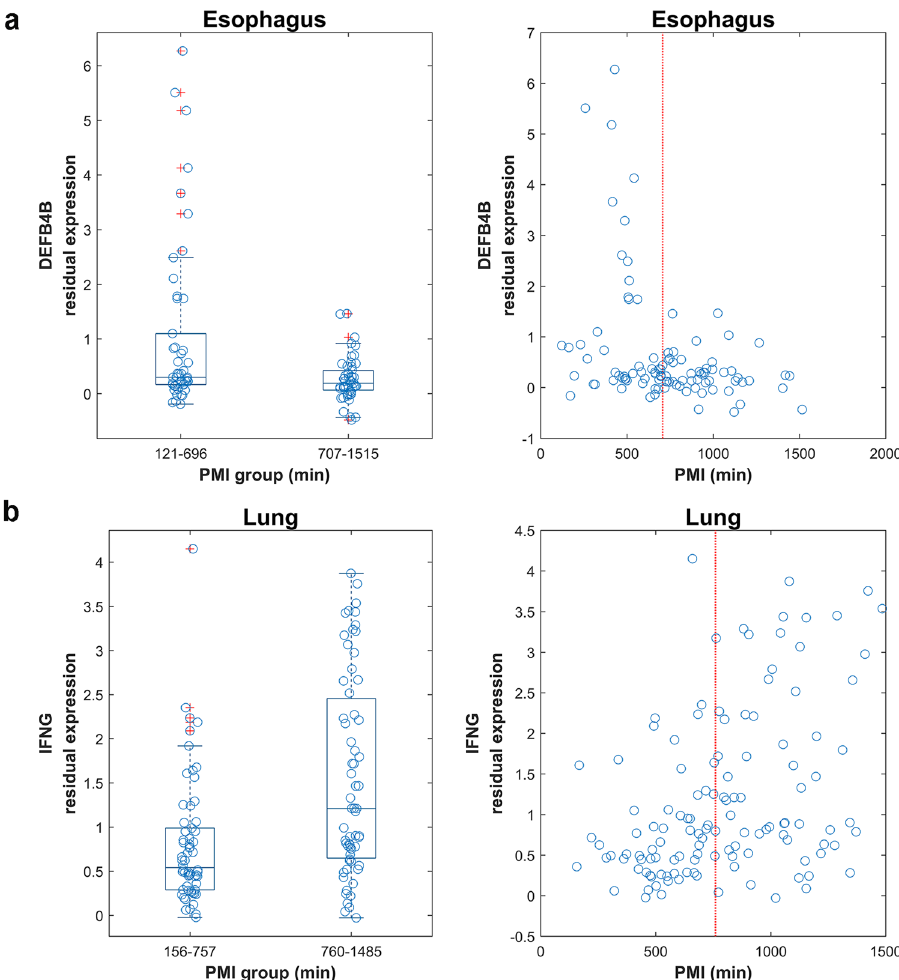
Figure 4. Examples of differential gene expression dispersion among PMI groups. ( a ) Increased gene expression variance of DEFB4B in esophageal mucosa between PMI groups (left:121–696 mins vs. 707– 1,515 mins; right: all samples). ( b ) Decreased gene expression variance of IFNG in lung between PMI groups (left:156–757 mins vs. 760–1,485 mins; right: all samples). Each PMI group was plotted with jitter along the x-axis to show samples of different PMI. The red dotted line represents the median PMI of all